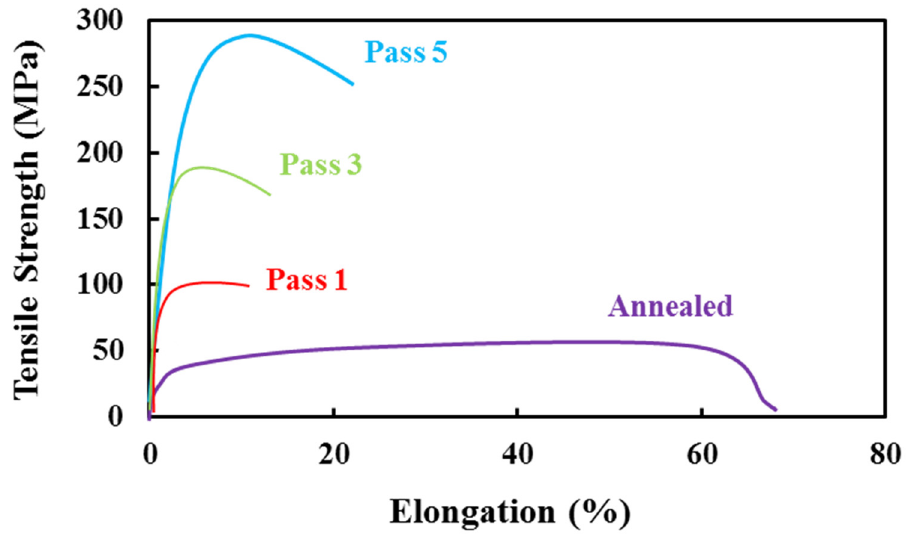
Figure 4. The stress–strain curves of the annealed sample and the 5 ARBed samples in the rolling direction.